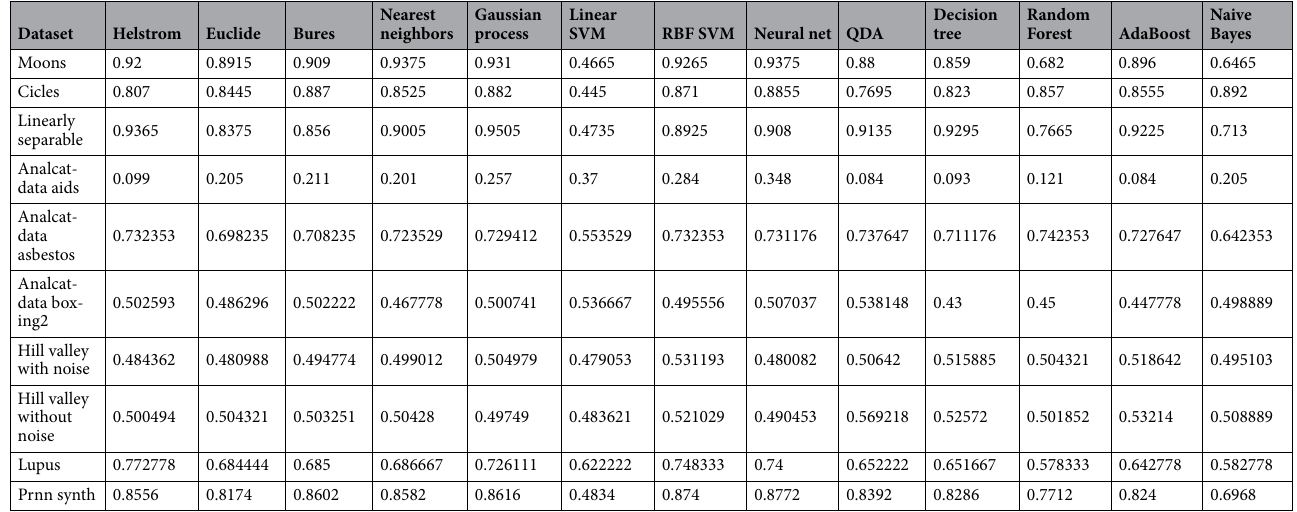
Table 6. Average accuracy with 2 features mapped into high-dimensional feature space ℝ 122